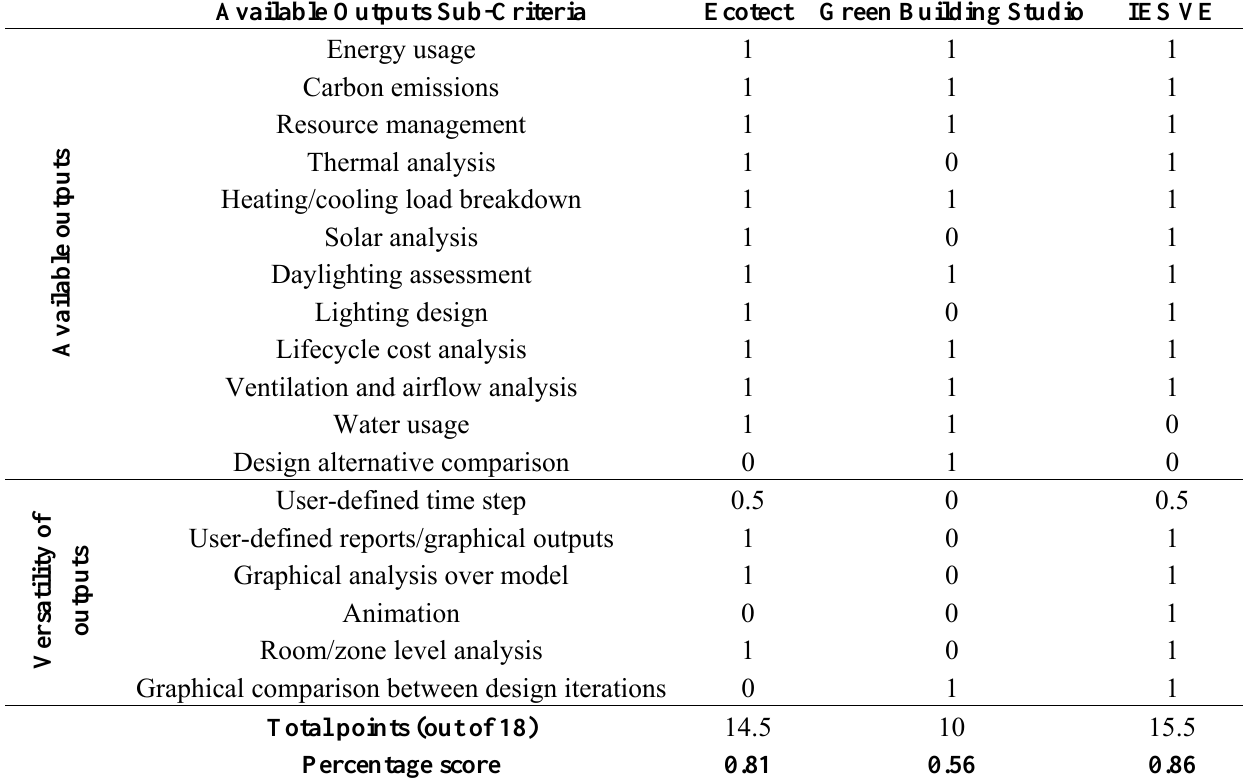
Table A10. Re-evaluation: available outputs criterion calculations for the top three BEM tools. Available Outputs